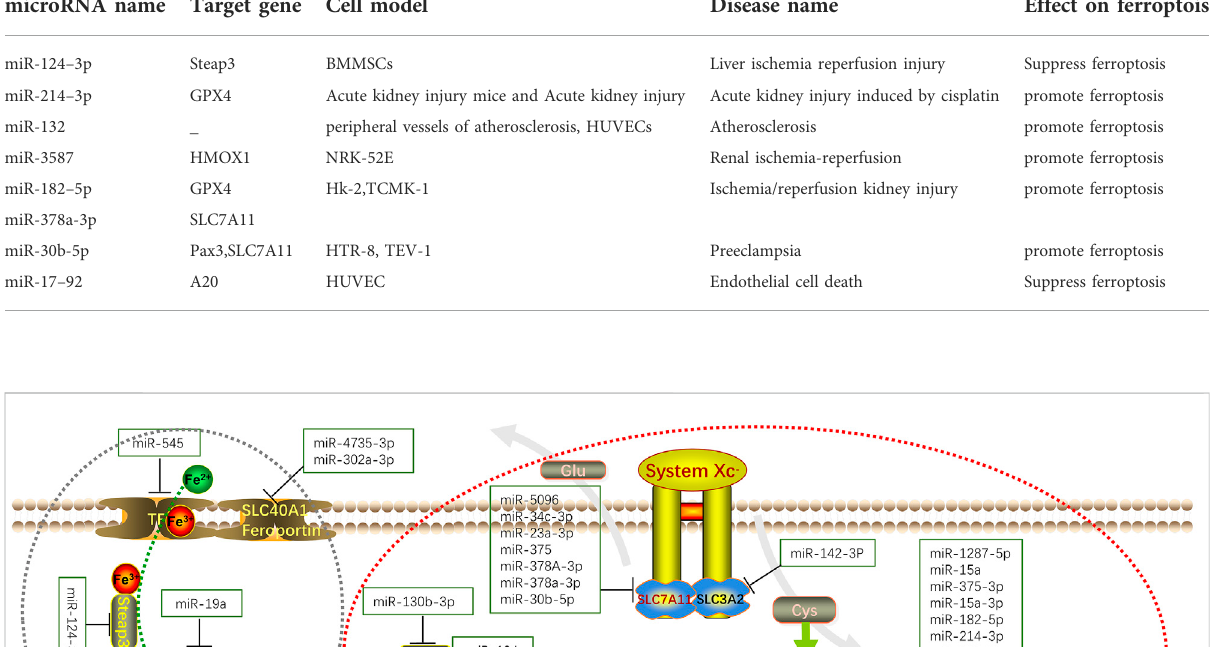
TABLE 4 The role of microRNA in ischemia-reperfusion via regulating ferroptosis.